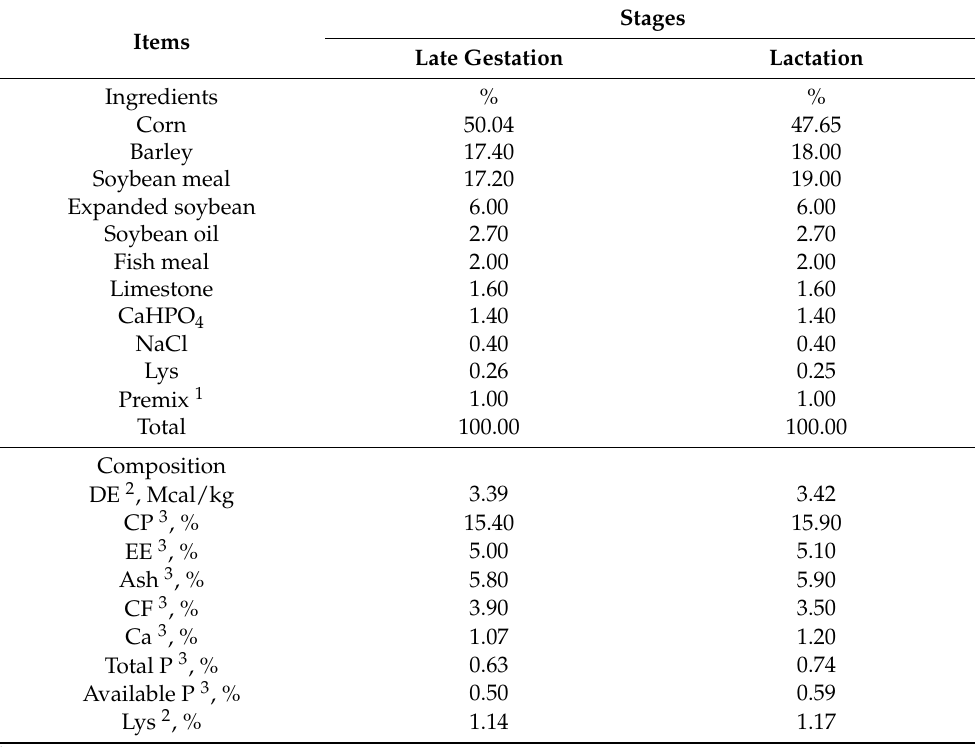
Table 1. The formulations and chemical composition of the basal diet (as-fed